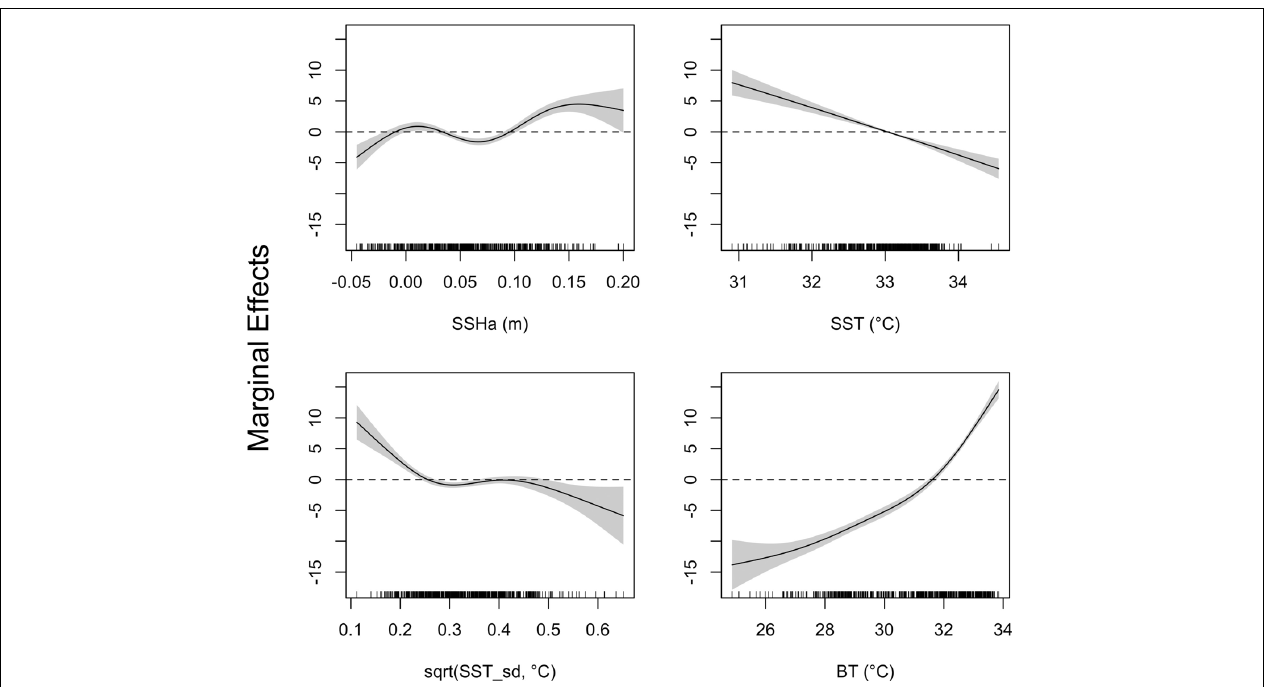
FIGURE 5 | Response curves of the GAMM investigating environmental drivers of turtle migrations to deeper water. Environmental covariates acronyms represent sea surface height anomaly (SSHa), sea surface temperature (SST), square-root transformation of SST standard deviation [sqrt(SST_sd)], and bottom temperature (BT). Shaded regions indicate the 95% confidence interval and tick marks on the bottom indicate all values for each environmental variable. Compared to the typical interpretation of GAMM response plots, the inverse is done here since depth (Z) was analyzed as negative